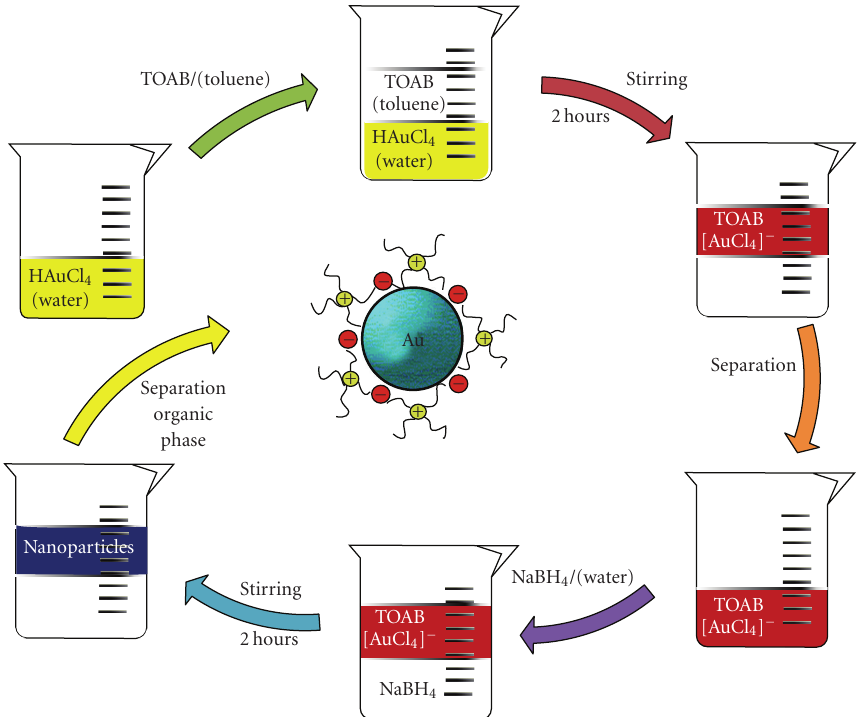
Scheme 1: Scheme showing the synthetic steps involved in the Brust synthesis of gold nanoparticles. The method can be used to synthesize platinum nanoparticles by replacing the precursor salt to H 2 PtCl 6 .